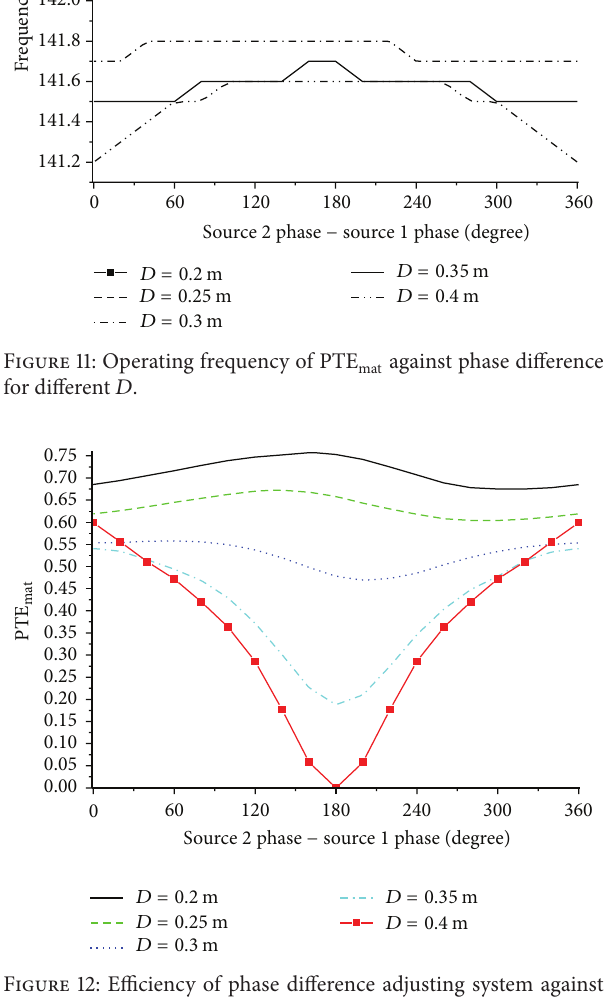
Figure 12: Efficiency of phase difference adjusting system against phase difference for different 𝐷 .